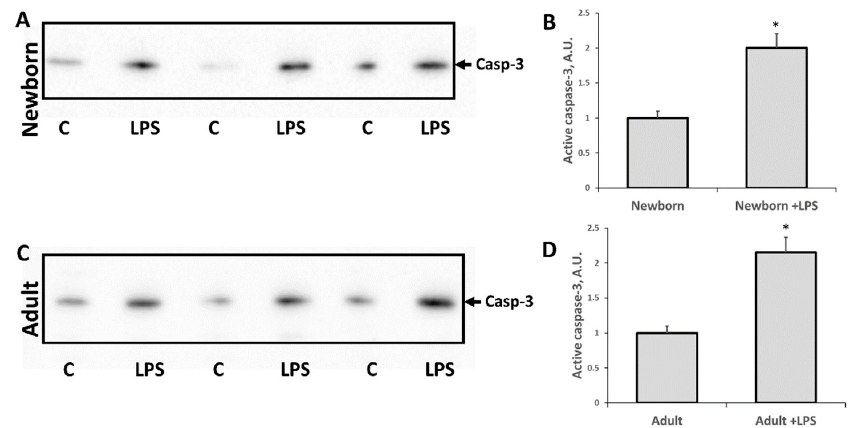
Figure 3. Induction of apoptosis in neonatal and adult kidneys 24 h after LPS treatment. Immunoblots for cleaved procaspase-3 (caspase-3, i.e., mature, active form) levels in kidneys of ( A , B ) neonatal rats and ( C , D ) adult rats. Densitometry analysis of bands in newborn and adults are presented in ( B ) and ( D ), respectively. Number of animals for western blot densitometry: Adult ( n = 6), Newborn ( n = 6), Adults + LPS ( n = 5), Newborn + LPS ( n = 5). *: p < 0.05.